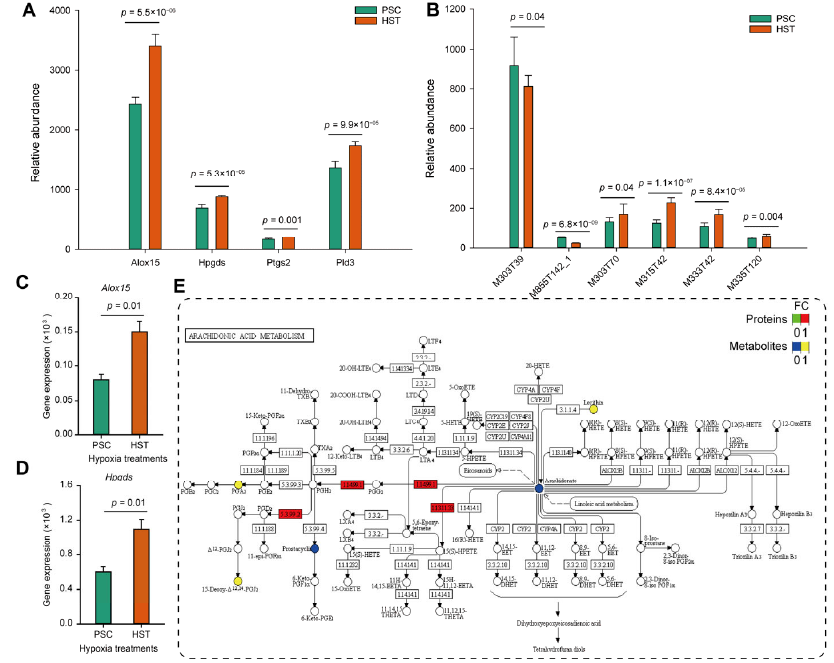
Figure 4. Working model representing the potential mechanism that arachidonate acid metabolism involved in hypoxia response. ( A ), Abundance of four proteins related to arachidonate acid me ‐ tabolism based on proteomics dataset. ( B ), Relative abundance of metabolites related to arachi ‐ donate acid metabolism based on metabolism dataset. ( C , D ), Relative expression of three genes related to arachidonate acid metabolism based on qPCR experiments. ( E ), Working model repre ‐ senting the biological roles of arachidonate acid metabolism involved in hypoxia response in mouse spleen. Different colors stand for the relative values of HST vs PSC for either protein or